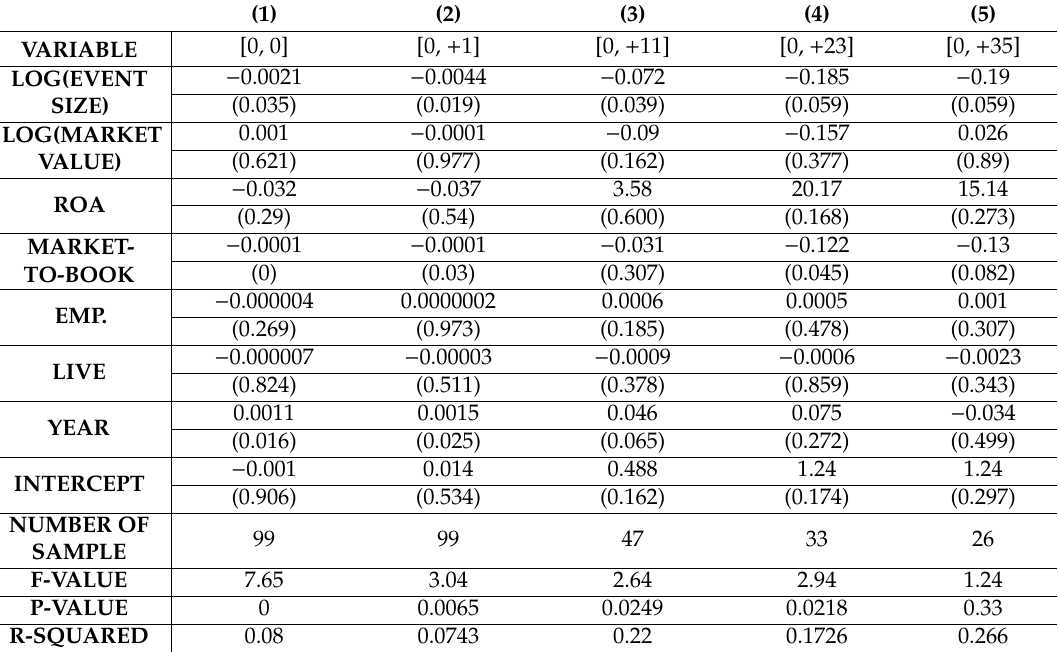
Table 8. Multiple regression